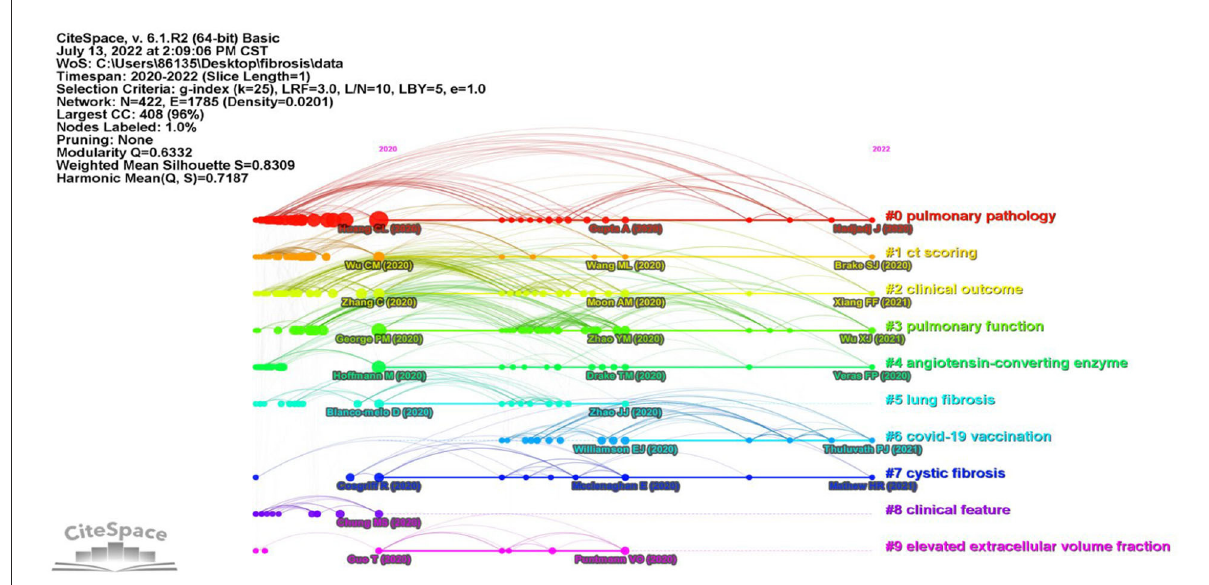
FIGURE3 References co-citation time view generated by CiteSpace. Colors indicated different reference clusters. Labels of clusters and main references were automatically generated by CiteSpace.